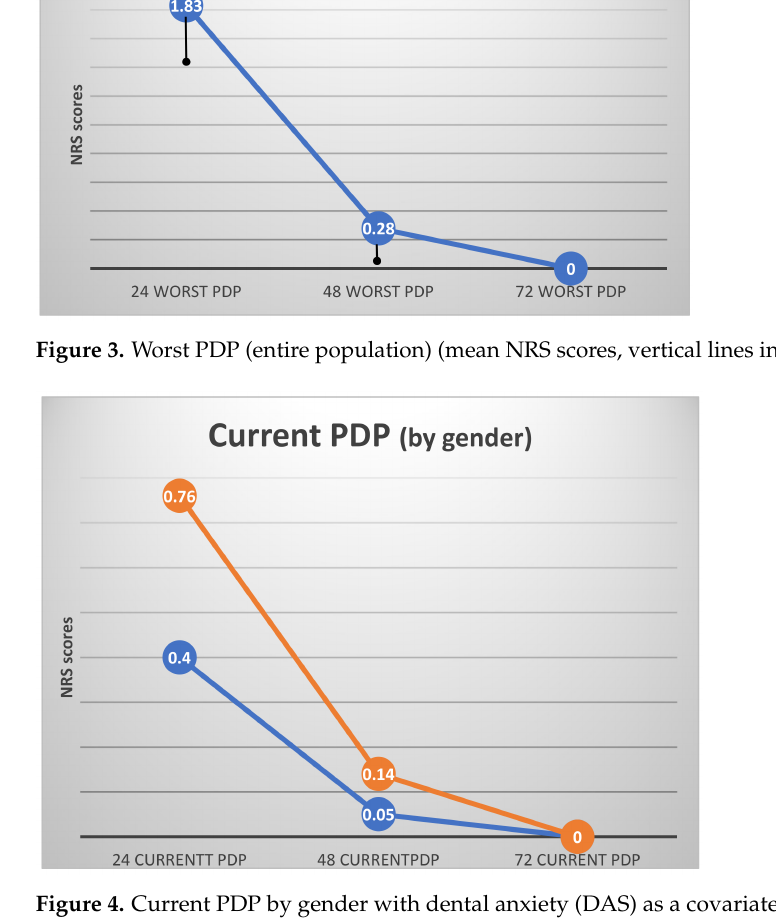
Figure 4. Current PDP by gender with dental anxiety (DAS) as a covariate (mean NRS scores with DAS as a covariate). Covariate appearing in the model evaluated at DAS = 8.8. Females—orange line, males—blue line.